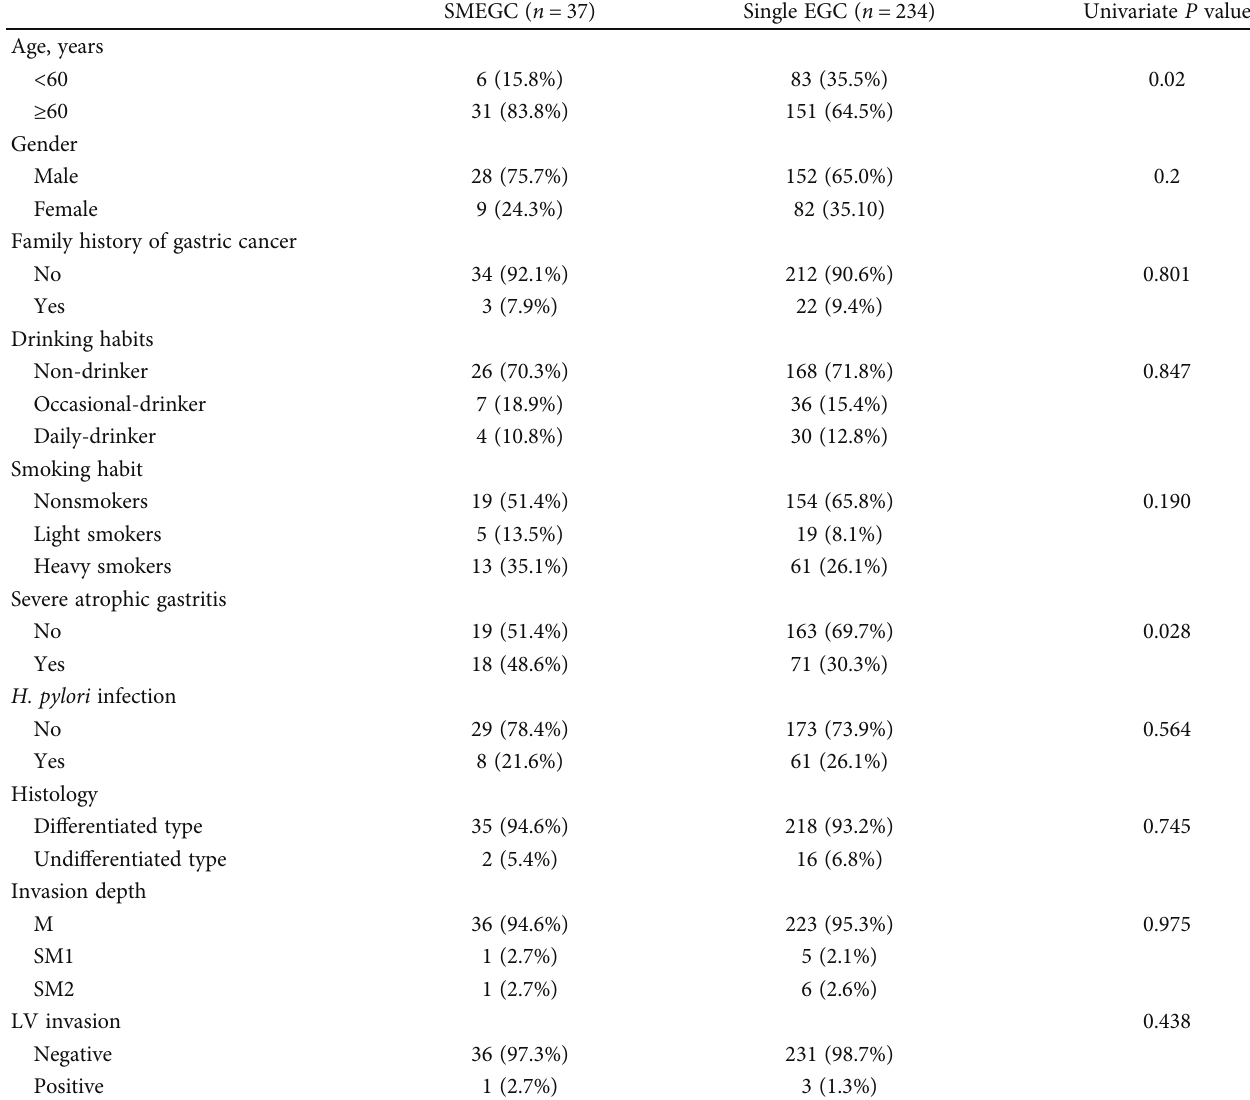
Table 1: Predictive factors of SMEGC compared with solitary EGC.